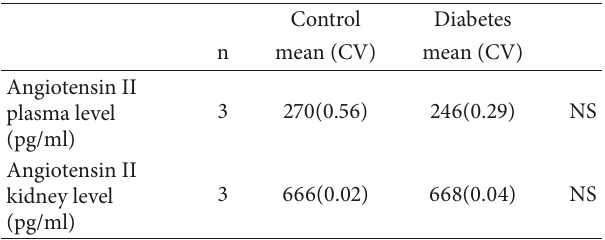
Table 2: Angiotensin II levels in the plasma and the kidney